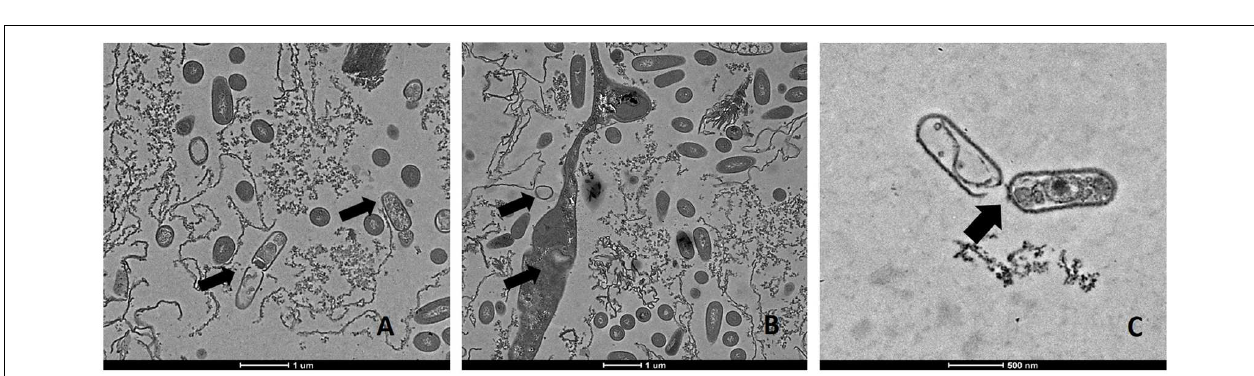
FIGURE 4 | Transmission electron microscopy (TEM) micrographs of L. monocytogenes Li-P69 cells treated with 1.2 J cm − 2 for 3 s. Scale bar equals 1 µ m (A–C) .